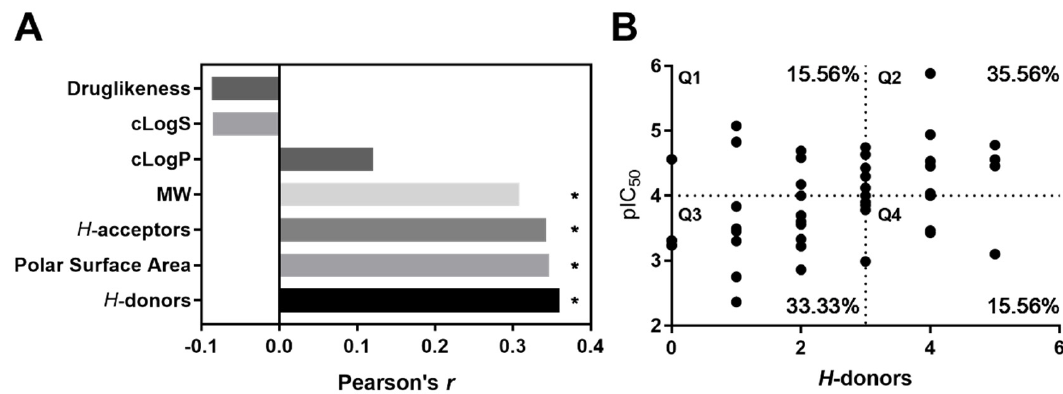
Figure 12. Correlation of molecular properties with antioxidant capacity in Streptomyces -derived metabolites. The properties druglikeness, cLogS, cLogP, molecular weight, H -acceptors, TPSA and H -donor were calculated by DataWarrior. ( A ) Pearson correlation coefficient between antioxidant capacity (pIC 50 ) and each calculated property. Asterisk indicates statistically significant correlation. ( B ) Dot plot of antioxidant capacity (pIC 50 ) against H -donor numbers. To evaluate the association of the property with the activity, a Fisher’s exact test was calculated ( p = 0.0174). Quadrant 1 (Q1), quadrant 2 (Q2), quadrant 3 (Q3) and quadrant 4 (Q4). In each quadrant, the percent of dots is presented.